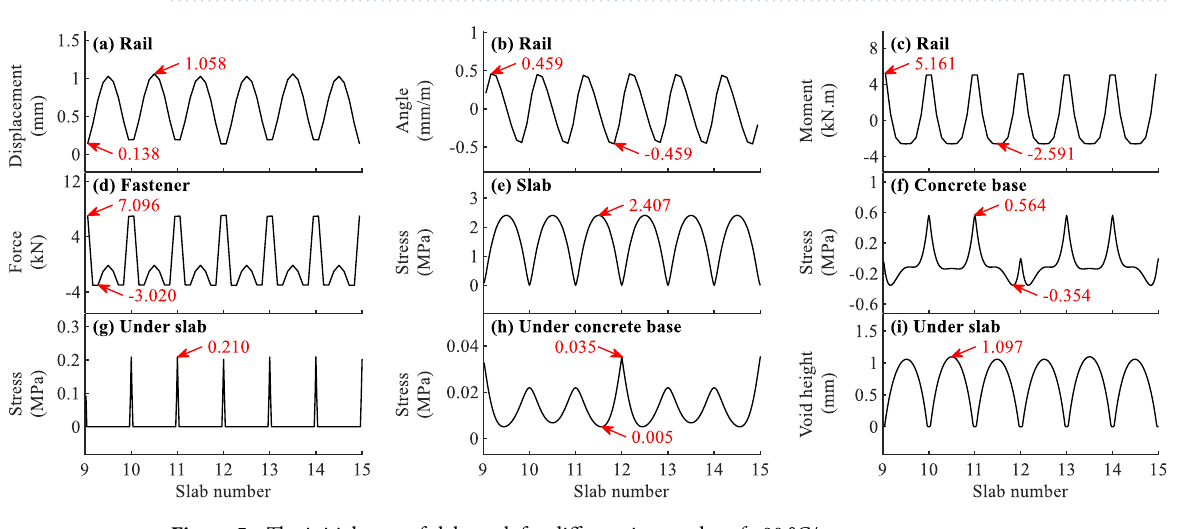
Figure 5. The initial state of slab track for different items when f = 90